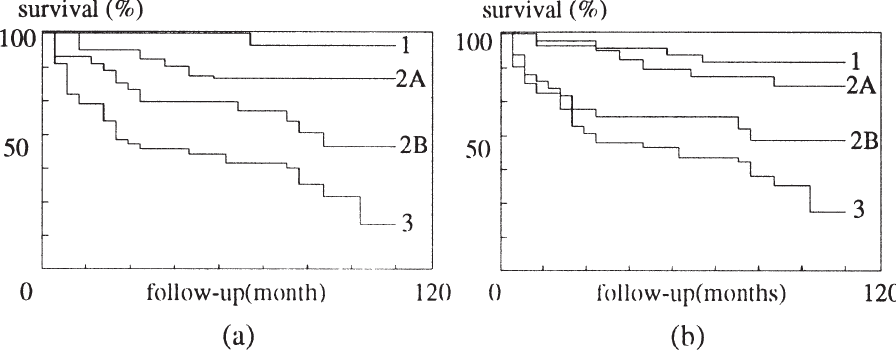
Fig. 7. The graphs were calculated according to the Kaplan–Meier method. (a) Survival related to subjective grade. (b) Survival related to texture analysis based